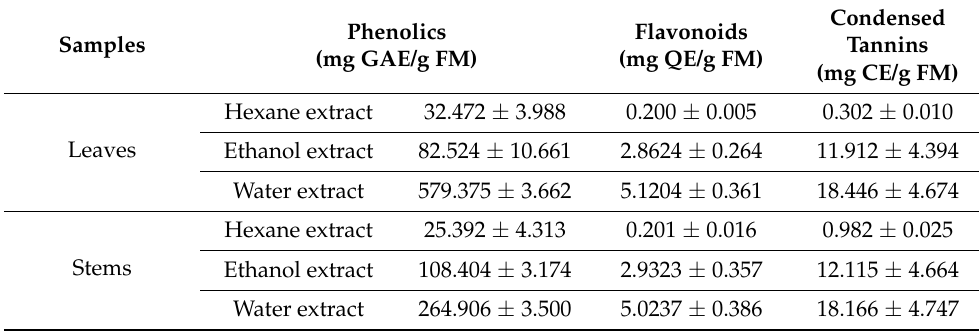
Table 3. Total phenolic, total flavonoid, and condensed tannin of cardoon waste extracts from Ultrasonic-Assisted Extraction method.